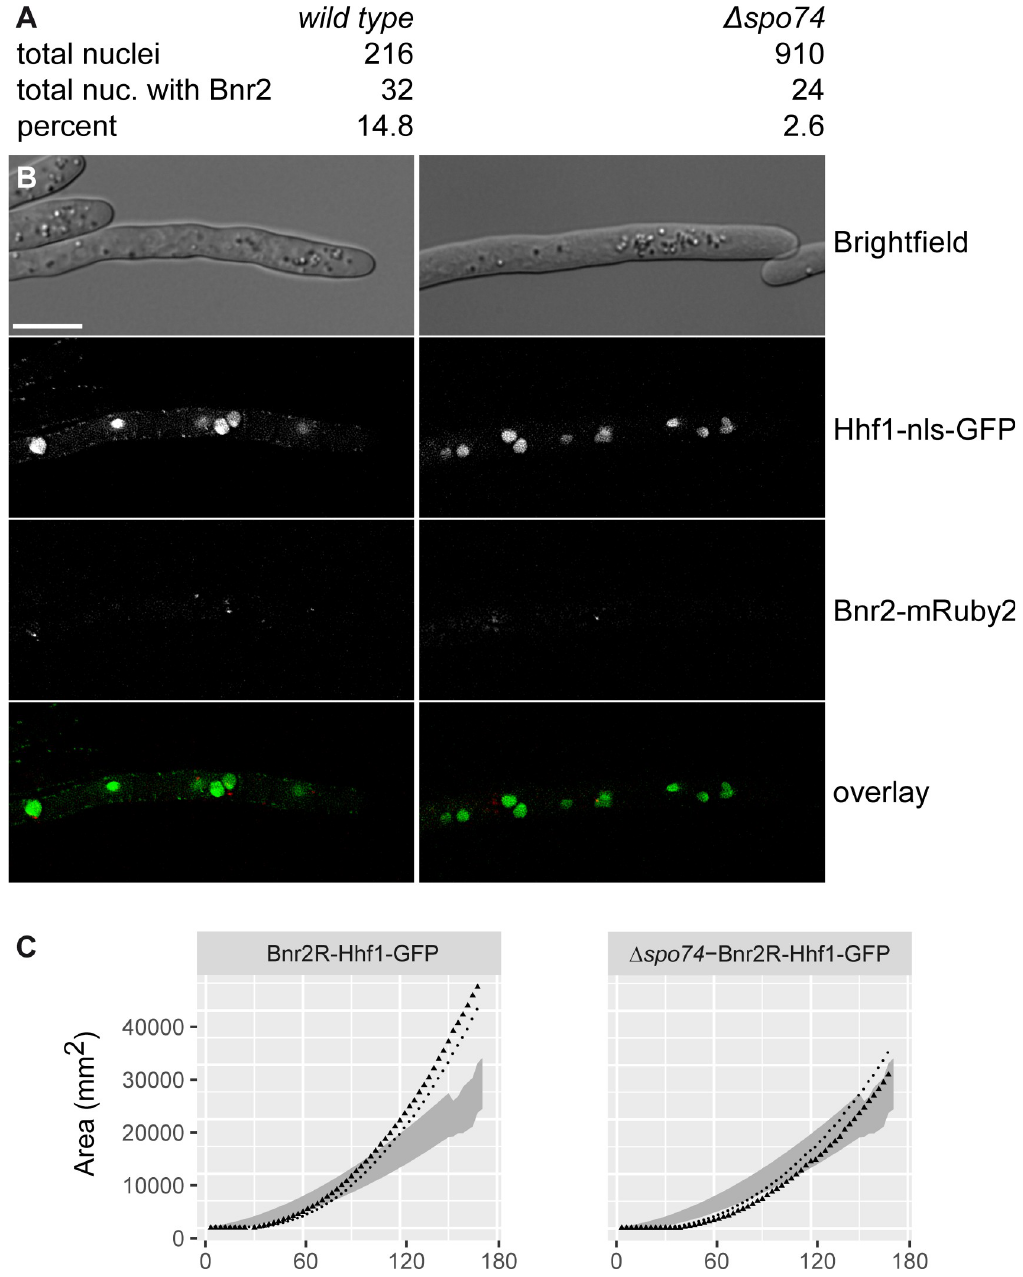
Fig 4. Quantification of AgBnr2 signals at nuclei of wild type and deletion mutants of Agspo74 . A) Numbers for total nuclei and total nuclei showing AgBnr2 signals together with the percentage of nuclei showing AgBnr2 signals. B) Representative sample image from the dataset. GFP fused to the nuclear localization signal of histone h4 (HHF1) was used to mark the nuclei. The scale bar represents 10 μ m. C) Radial growth of the strains from above. The graph represents the area of the mycelium growing (in mm 2 ) measured every 3 hours over the indicated time